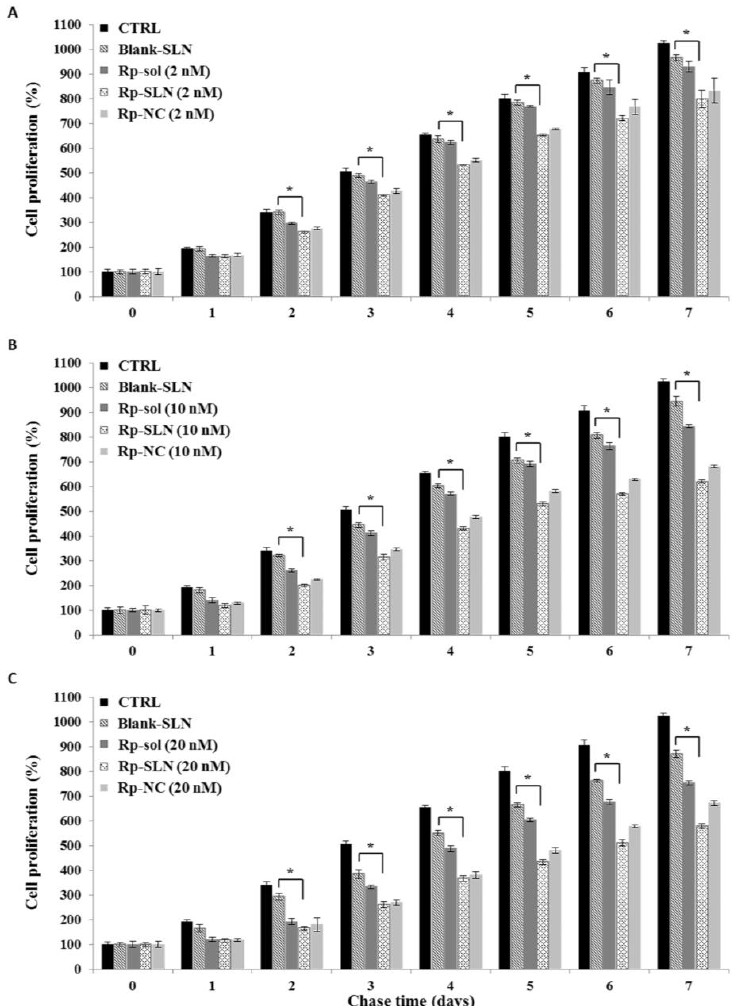
Figure 9. Effect of the Rp treatments on cell proliferation. The Rp effect was evaluated in SH-SY5Y cells by pulse-chase experiments. Cells were seeded in a 96-well plate, incubated overnight at 37 °C and treated for 4 h with Rp solution (Rp-sol), Rp-nanocrystals (Rp-NC) and Rp-SLN at the concentration of 2, 10 and 20 nM (Pulse), panel ( A – C ), respectively. The cells were also treated with blank SLN as control. The cell proliferation was evaluated daily by using 3-[4,5-dimethylthiazol-2-yl]-2,5-diphenyltetrazolium bromide (MTT) assay. Control (CTRL): untreated cells. Values are the mean ˘ S.D. of three independent experiments. * p < 0.01 (Rp-SLN vs. blank SLN cells) according to unpaired two-tailed Student’s t